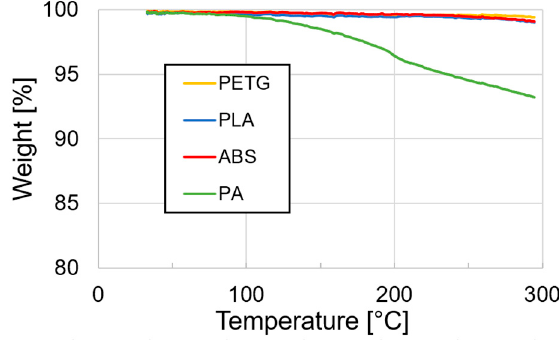
Figure 6. TGA data of the four different candidate polymers.